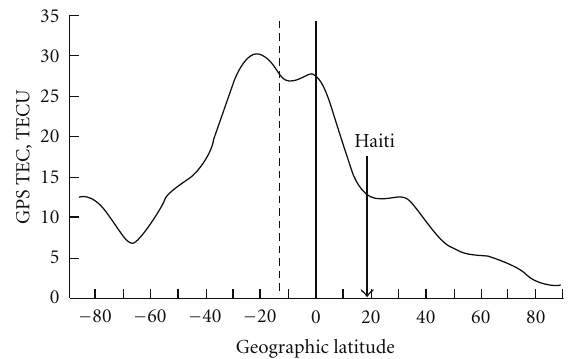
Figure 13: Configuration of the equatorial anomaly in relation to the geodetic equator position at the longitude of Haiti M7.9 earthquake on January 12,